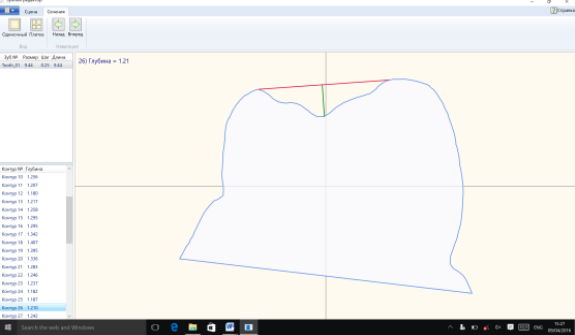
Figure 11. Automated landmark setting and measurements on tooth